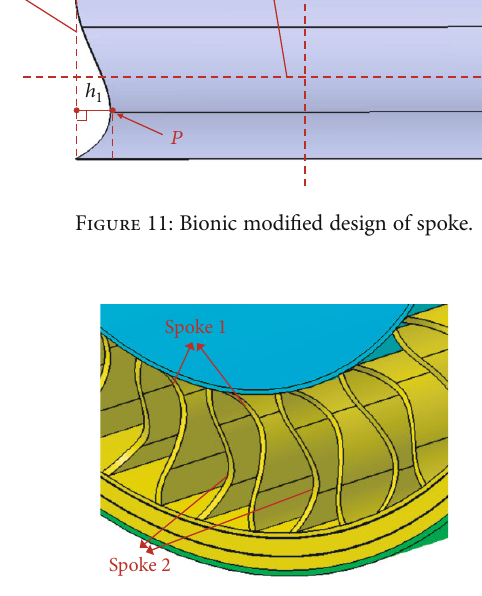
Figure 12: Asymmetrical arc structure of spoke pair.